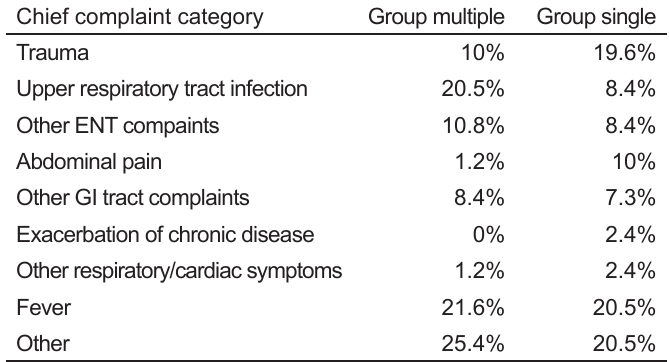
Table 2 . Information regarding nature of chief